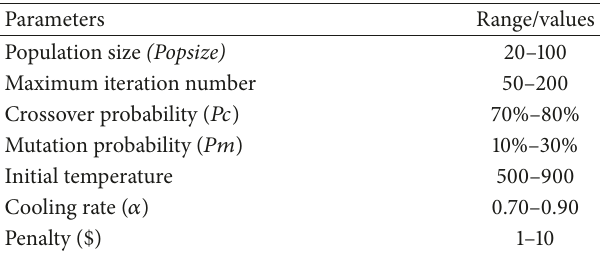
Table 1: Machining data. Table 2: HSAGA